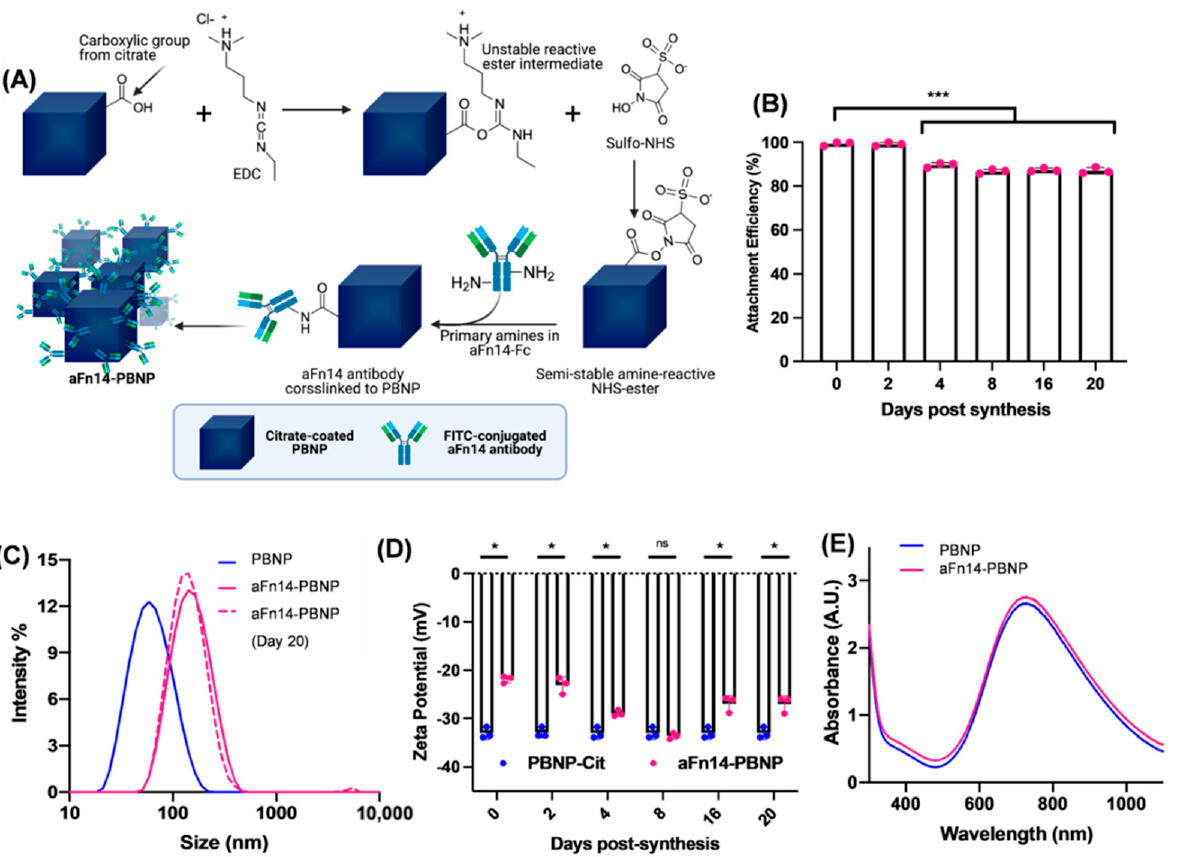
Figure 1. aFn14 can be covalently conjugated to PBNPs to generate stable aFn14-PBNPs. ( A ) Synthesis scheme used to generate aFn14-PBNPs, described in Methods 2.2. EDC-NHS chemistry was used to coat FITC-conjugated aFn14 antibody onto the surface of the PBNPs. The carboxyl groups from citrate on the surface of PBNPs are covalently conjugated to the amine groups on aFn14. ( B ) Attachment efficiency of aFn14 on to PBNPs over time. The initial attachment efficiency on Day 0 (99.4% SD 0.88%) did not significantly change on Day +2, but a statistically significant change was observed after Day +4 to a final attachment efficiency of 87.1% (SD 1.48%) by Day 20 ( p < 0.0001). ( C ) Size distributions of PBNPs and aFn14-PBNPs as measured by dynamic light scattering. The size shift between PBNP and aFn14-PBNP indicates successful attachment of aFn14. There was no size change of aFn14-PBNP between Day 0 after synthesis (pink line) and Day 20 (dotted pink line), demonstrating long-term stability of aFn14-PBNPs. ( D ) Zeta potentials of PBNPs and aFn14-PBNPs. Statistically significant differences in the surface charge were observed between PBNPs and aFn14-PBNPs at all time points (except Day +8). This suggests the presence of the aFn14 antibody on the surface of aFn14-PBNPs. ( E ) UV-Vis-NIR spectra demonstrating the characteristic absorption peak of PBNP between 650–900 nm, which yields NIR responsiveness at 808 nm. Coating with aFn14 did not affect this absorption property. Welch’s t -test was utilized to test for statistical significance. * = p < 0.05 ** = p < 0.01 *** = p < 0.001; ns = not significant.